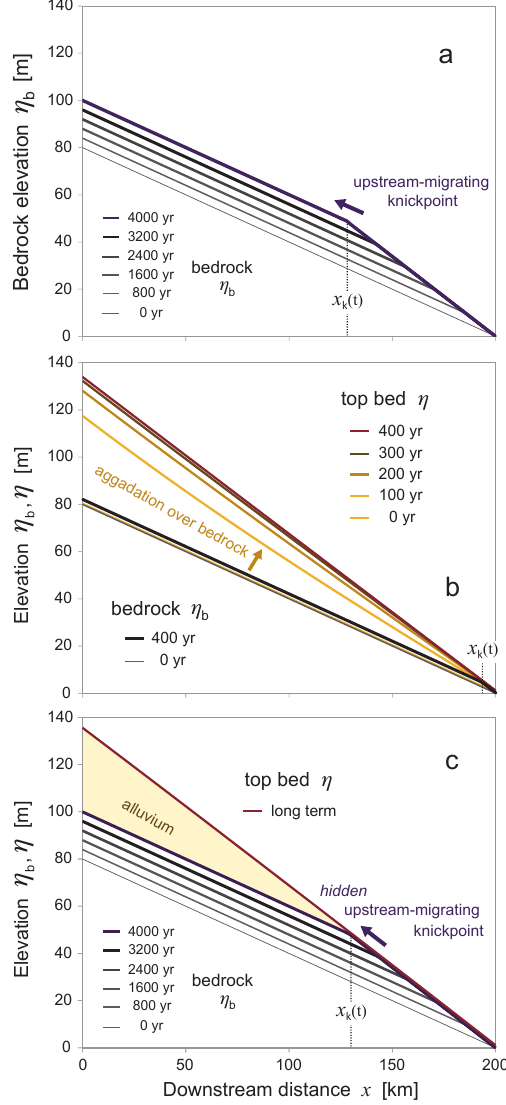
Figure 13. Progression to steady state after an impulsive increase in sediment supply: (a) CSA model; (b) MRSAA model, early stage; and (c) MRSAA model, late stage. Note the knickpoints x k (t) in bedrock in (a) and (b) and hidden in a migrating alluvial–bedrock transition in (c) . Here η denotes elevation of the top bed surface, η b denotes elevation of the base of bedrock relief, and x denotes streamwise distance. The retreating alluvial wedge is shaded in (c) for